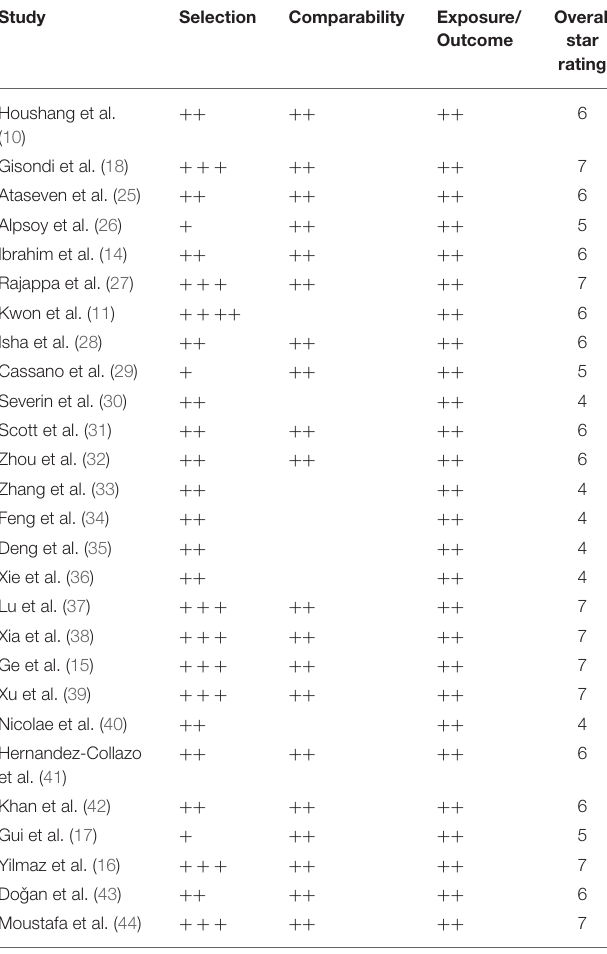
TABLE 2 | Newcastle-Ottawa Scale (NOS) quality assessment table.